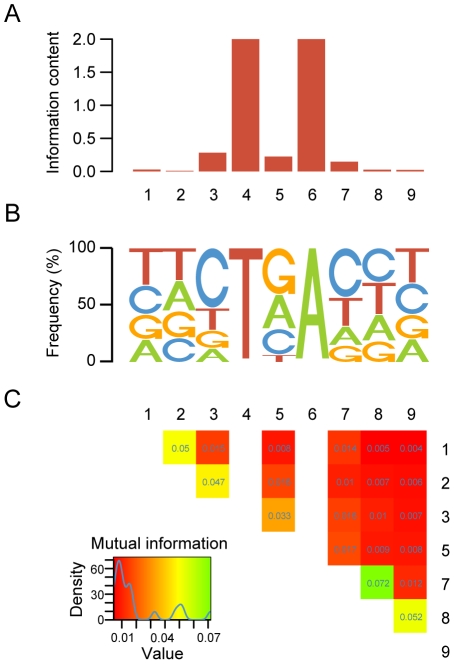
BP signal characterization.
A – Information content per motif position. Both position 4 and 6 were previously fixed. B – Sequence logo for the consTNA-BP5 set. The height of each letter represents the frequency of that nucleotide in the respective position. C – Mutual information between BP signal positions. Blank spaces represent the two invariable positions 4 and 6.